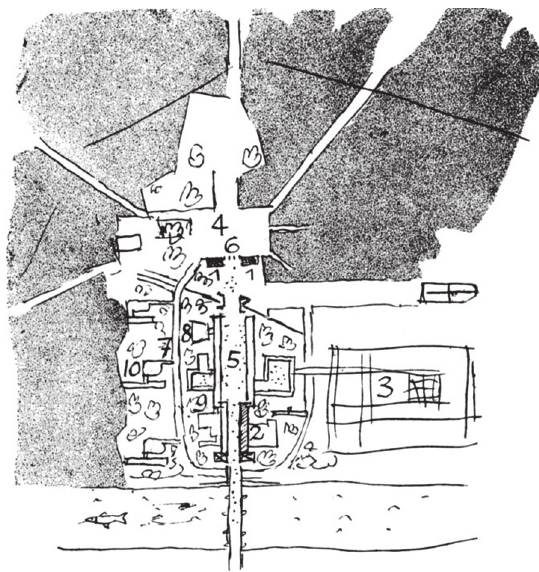
fig. 10. a draft proposal to transform the old city of orléans (le Corbusier